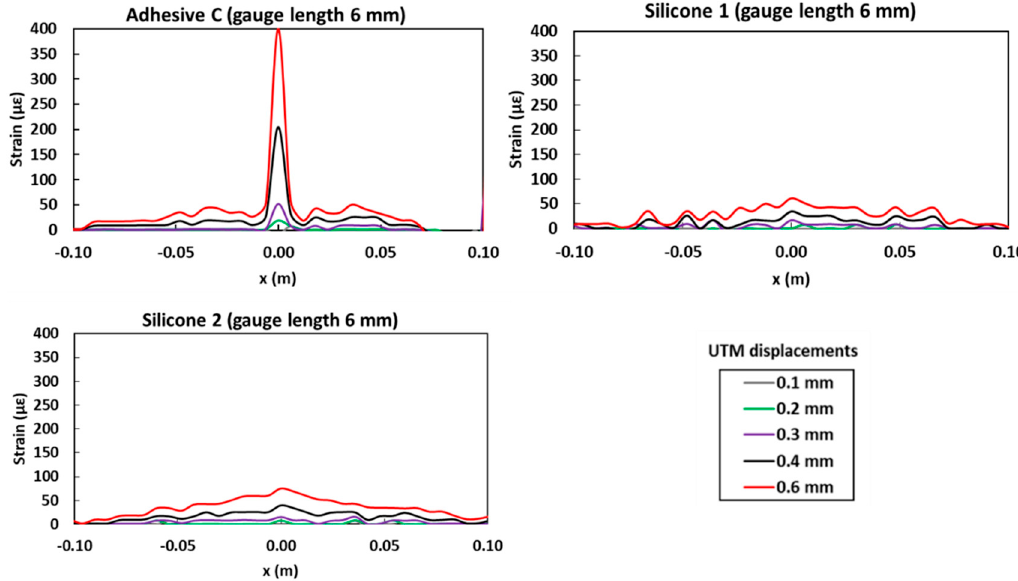
Figure 13. Strain profiles recorded by DOFS bonded to the concrete specimen with three soft adhesives (Adhesive C, Silicone 1, and Silicone 2).